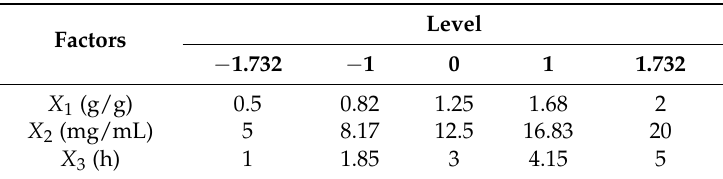
Table 3. Factor levels for the central composite